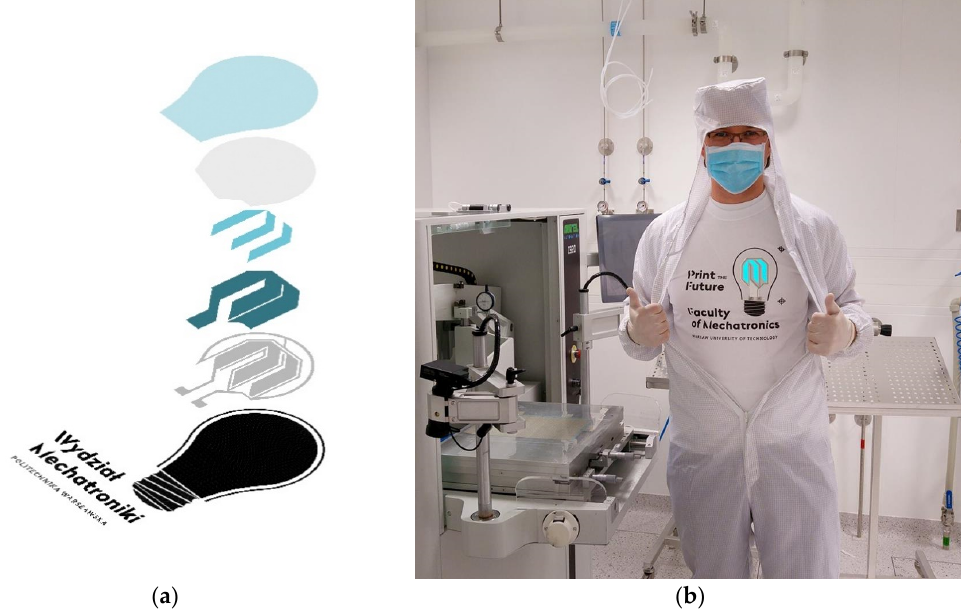
Figure 1. Schematic cross-section of the prepared printed electroluminescent structure (from the top: transparent protective layer, upper transparent electrode, electroluminescent layer, dielectric layer, lower electrode, protective layer), ( a ) Work results ( b ). Nanomaterials 2019 , 9 , x FOR PEER REVIEW